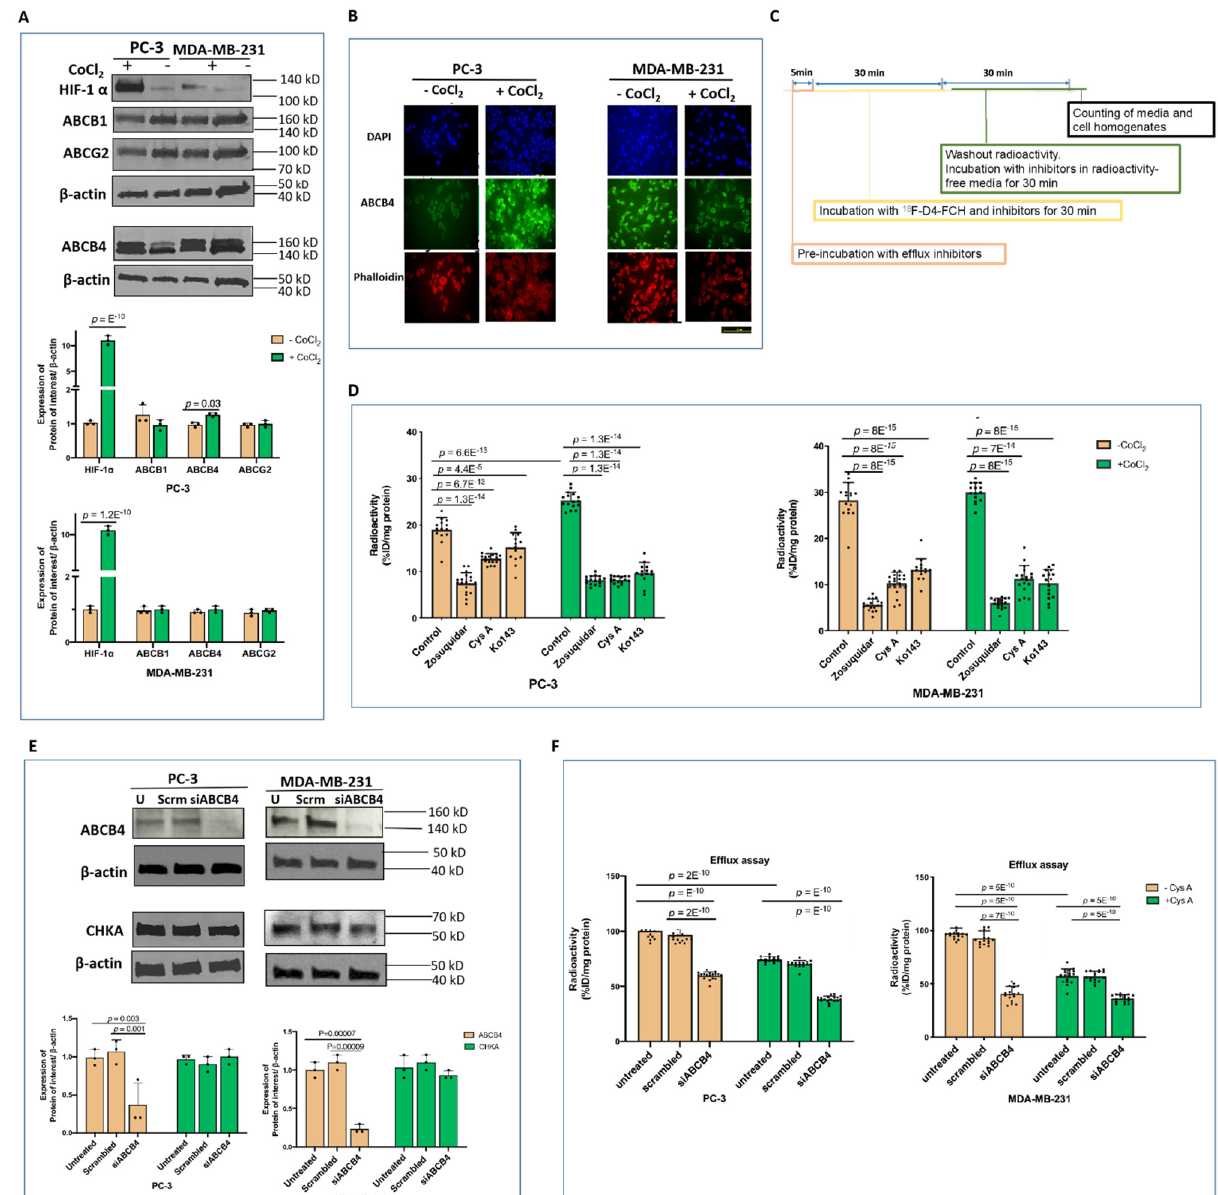
Figure 4. The role of ABCB4 in the modulating efflux of [ 18 F]-D4-FCH. ( A ) The immunoblots of PC-3 and MDA-MB-231 cells following the CoCl 2 treatment. ( B ) Immunofluorescence: DNA stained by DAPI (blue) and cytoskeleton staining by phalloidin (red) and co-stained with ABCB4 (green). ( C ) The workflow of the efflux assay of [ 18 F]-D4-FCH. The cells were pretreated with efflux inhibitors ABCB1 (1 µM zosuquidar), ABCG2 (3 µM ko143), or ABCB4 (10 µM cys A) for 1 h in a coincubation with 0.37 MBq [ 18 F]-D4-FCH under the standard conditions. ( D ) Efflux assay; the method was described in B. ( E ) Immunoblots of the ABCB4 knockdowns. Upper, immunoblots of the PC-3 and MDA-MB-231 cells. Lower, densitometry. ( F ) Efflux activity of the radiolabelled choline species of the ABCB4 knockdowns from E.